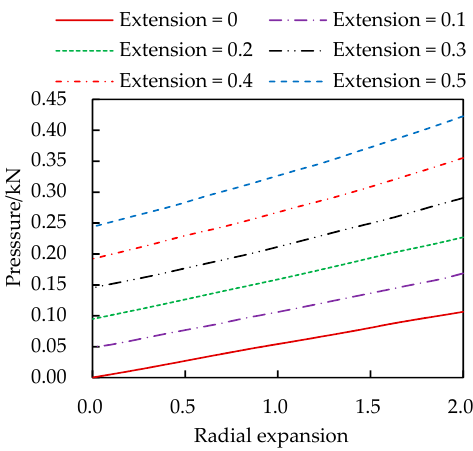
Table 2. Possible deformation data under specific loads.